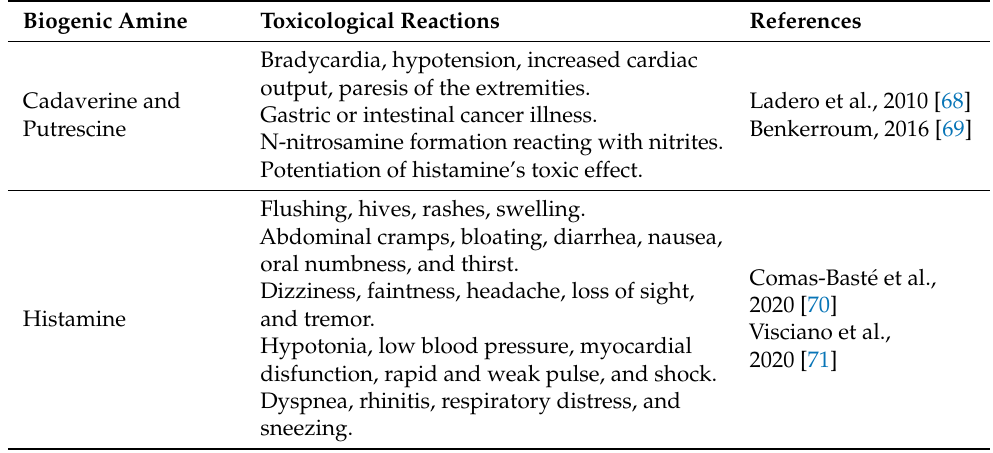
Table 5. Main toxicological effects of biogenic